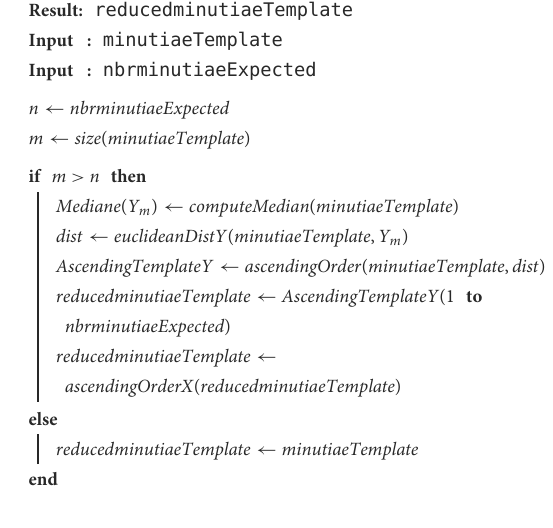
Algorithm 4. Median Y